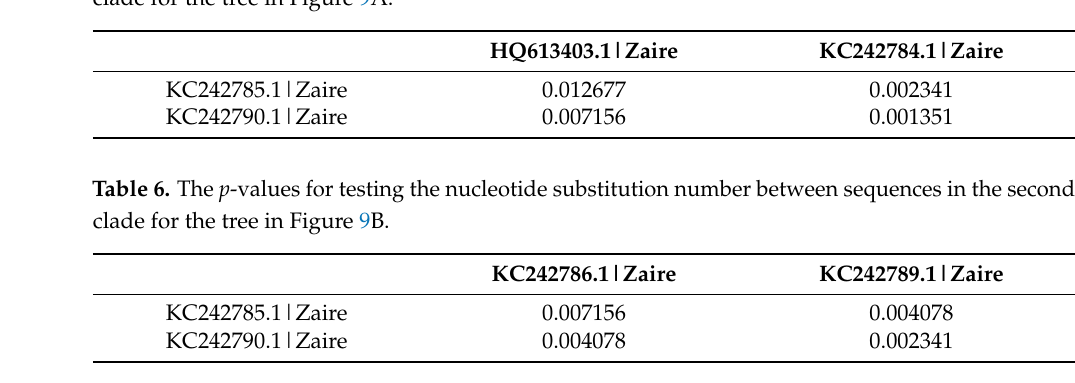
Table 7. The numbers of p -values less than k in the second clade for the trees in Figure 9. The difference between these two models is marked by the red color in the JC69 model. Substitution Model 0.01